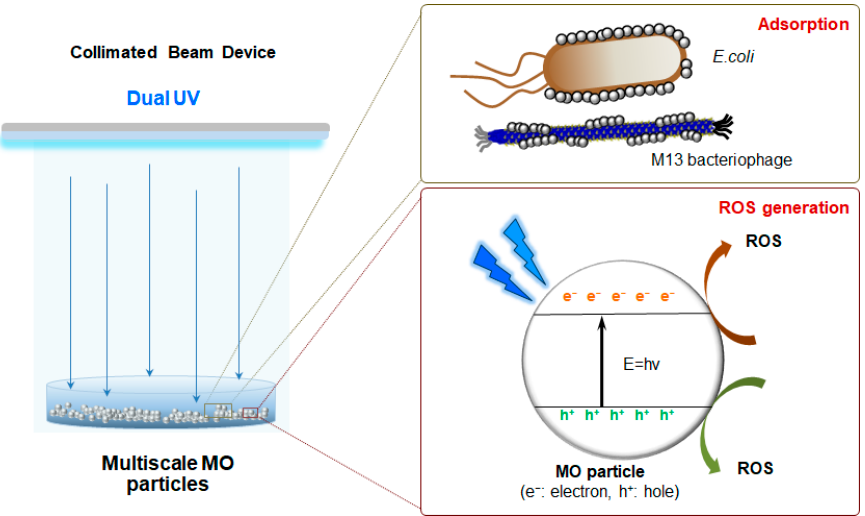
Figure 7. Schematic diagram of main antimicrobial mechanisms of a dual ultraviolet (UV)-multiscale metal oxide (MO) particle system for enhanced antimicrobial action. In water, multiscale MO particles were adsorptive to E. coli and phage resulting in biomembrane rupture and cell death. They generated reactive oxygen species (ROS) under dual UV irradiation promoting an electron from valence band to conduction band by a band gap energy.